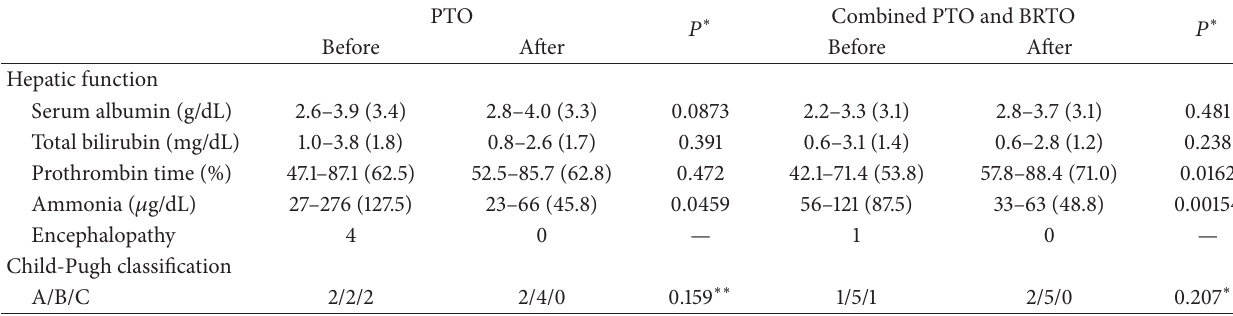
Table 3: Changes in hepatic